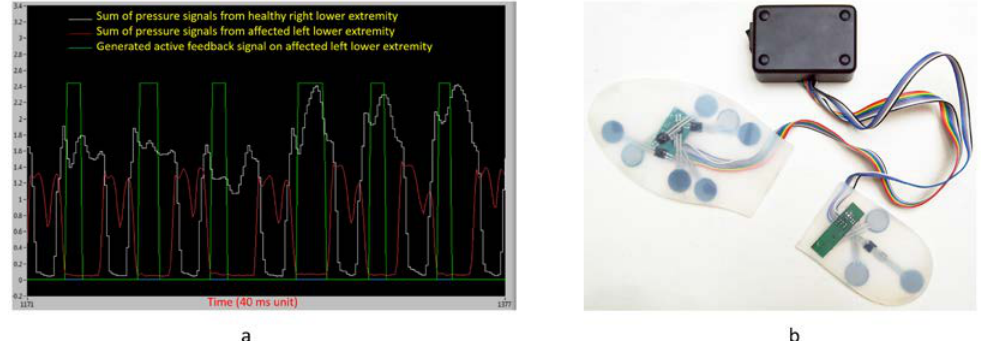
Figure 4. ( a ) Pressure sensor signals for asymmetric walking of a post-stroke subject and generation of active feedback [95]; and ( b ) biofeedback system presented by Bamberg et al. for stroke patients